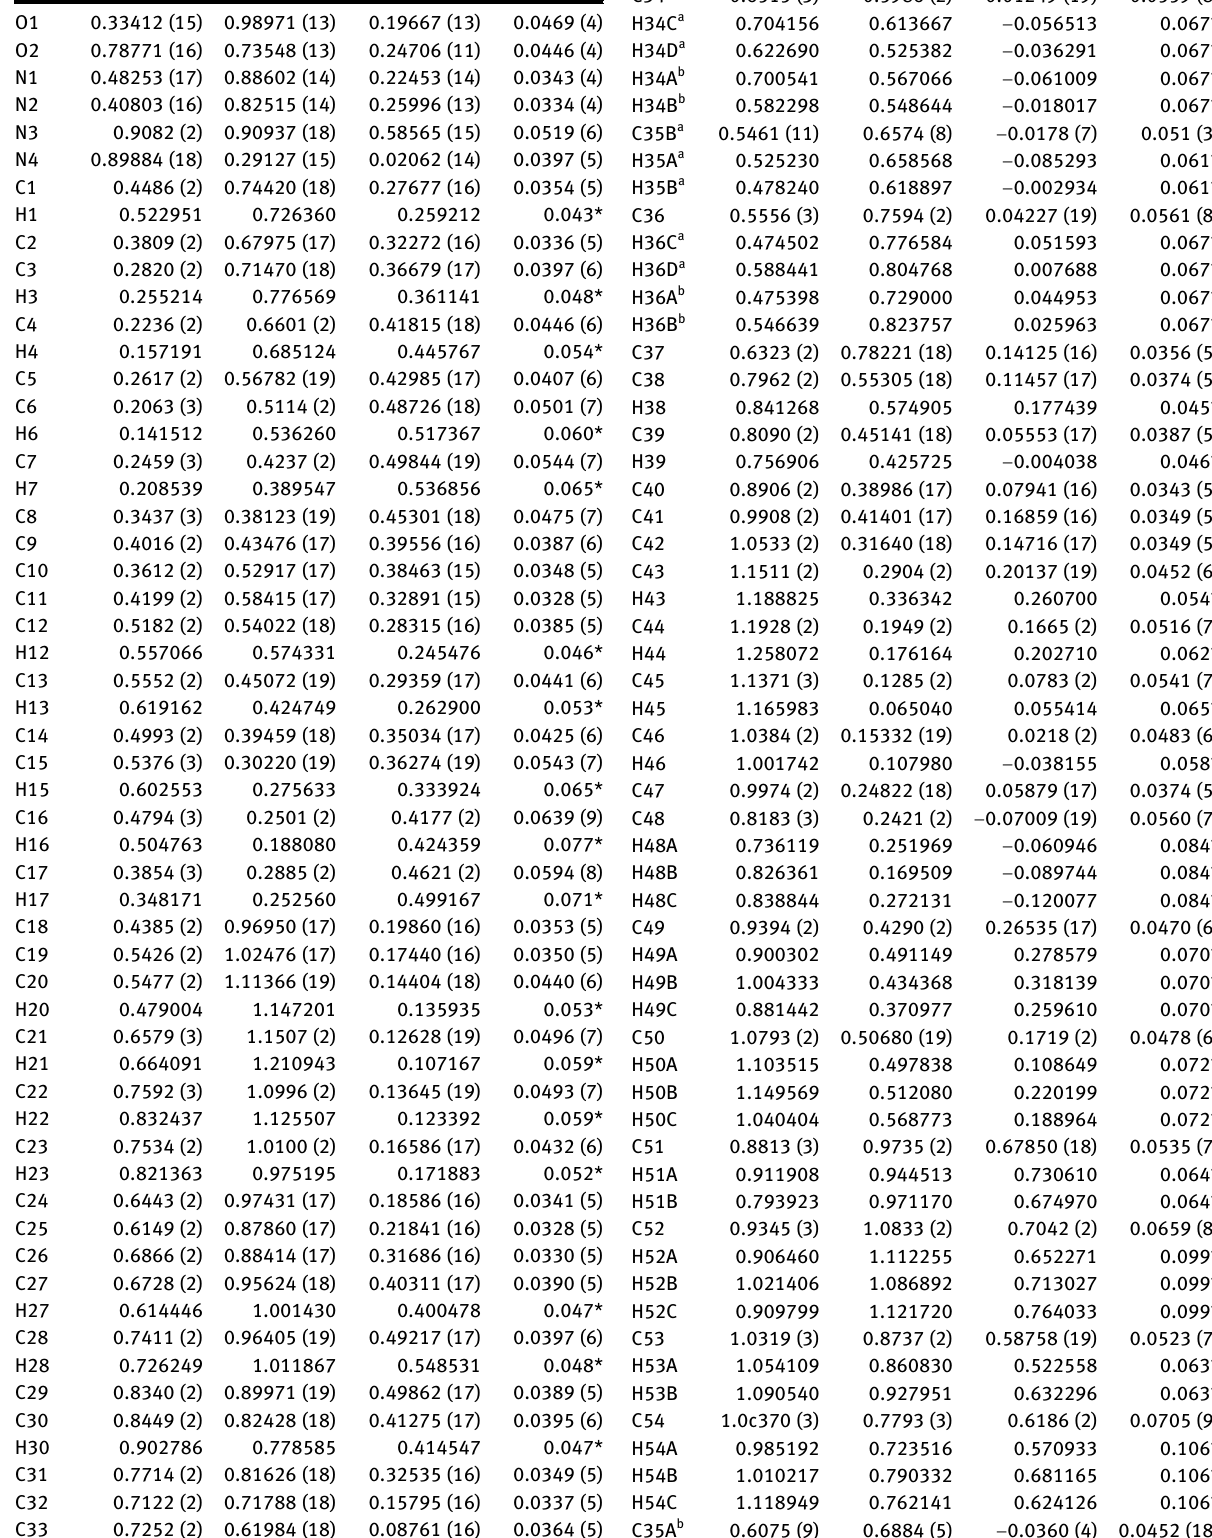
Table  : Fractional atomic coordinates and isotropic or equivalent isotropic displacement parameters (Å  ).